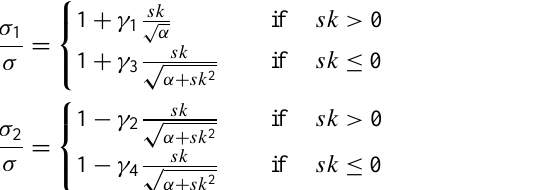
LES cases in (a). The legend in (a) also applies to (b).